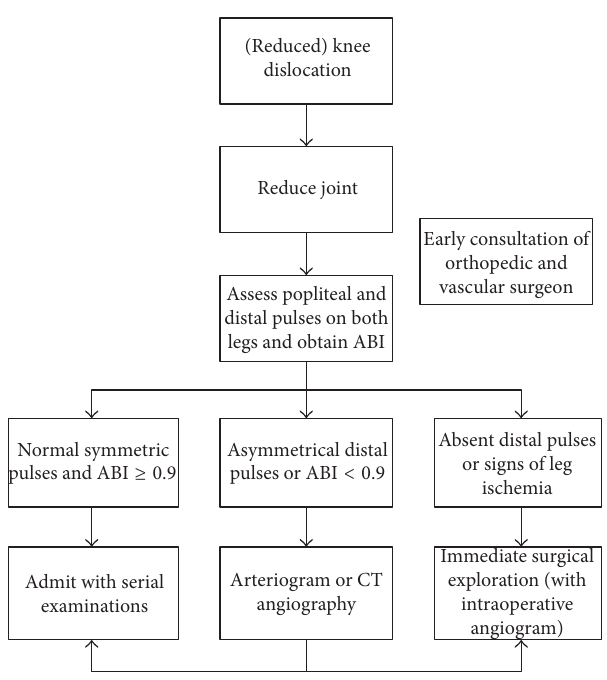
Figure 4: Algorithm of selective angiography approach in patients with knee dislocation (adapted from Boyce et al.